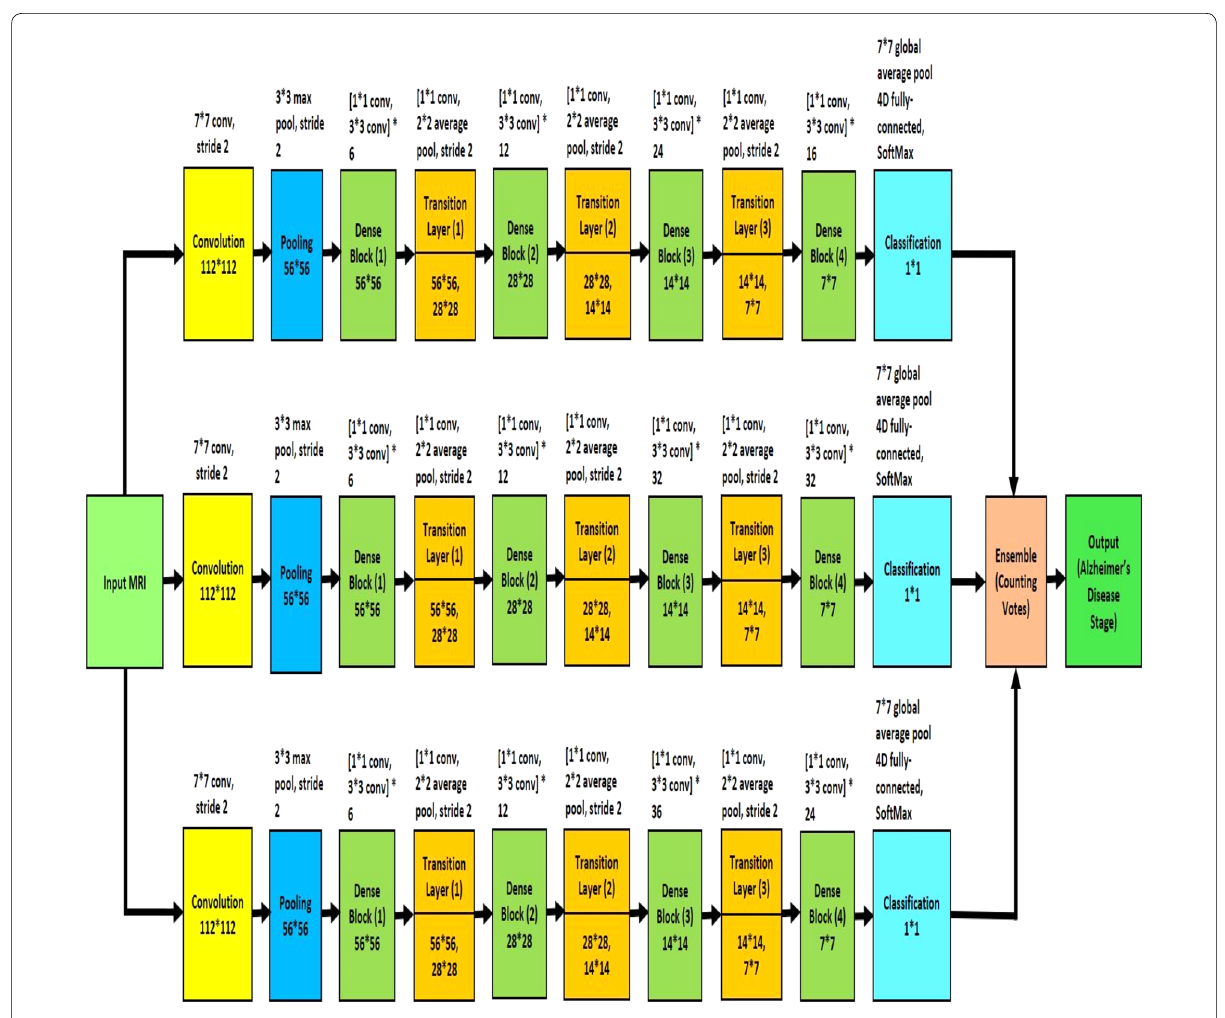
Fig. 5 Block diagram of proposed Alzheimer’s disease diagnosis